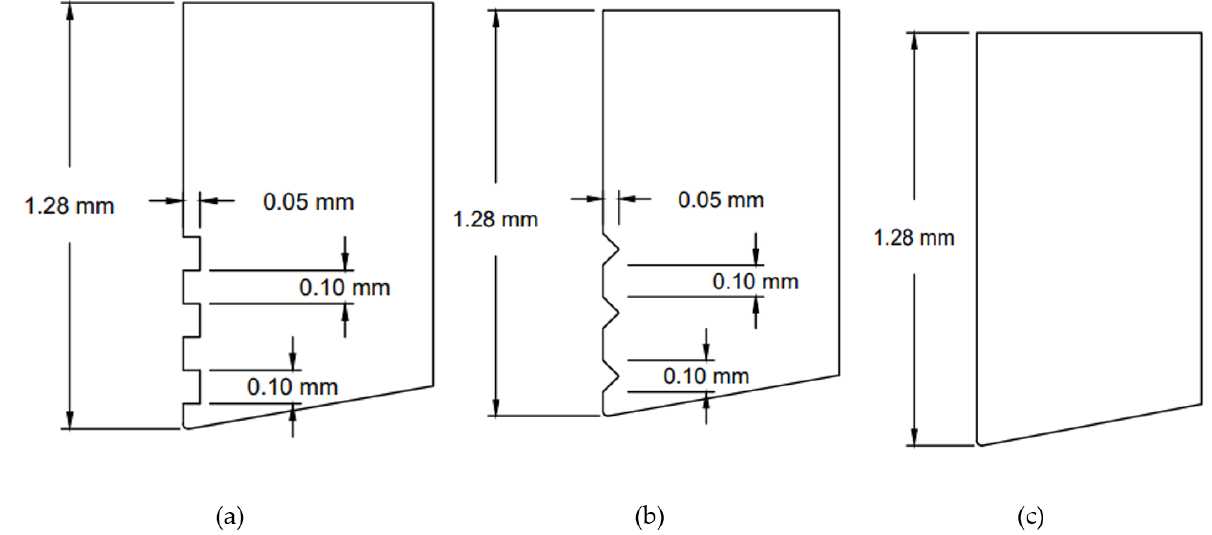
Figure 1. Microgrooves on the cutting tool, ( a ) rectangular ( b ) V-shaped or triangular and ( c ) flat tool. Table 1. Parameters of Microgrooves. Parameters RT Tool VT Tool